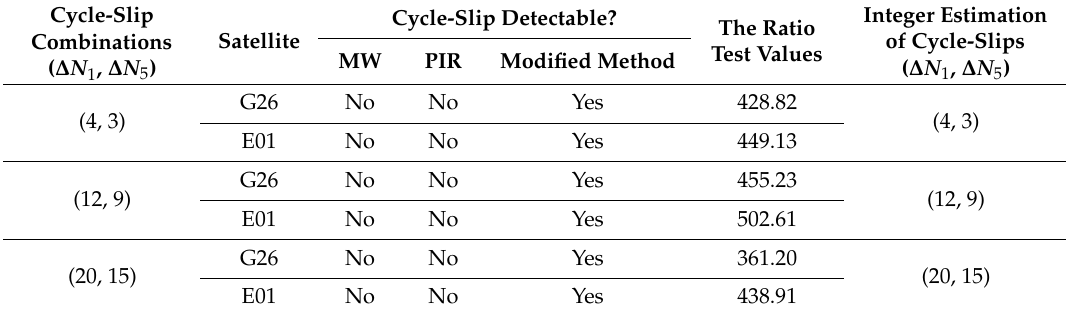
Table 2. Summary of the specific small cycle-slips detection and correction